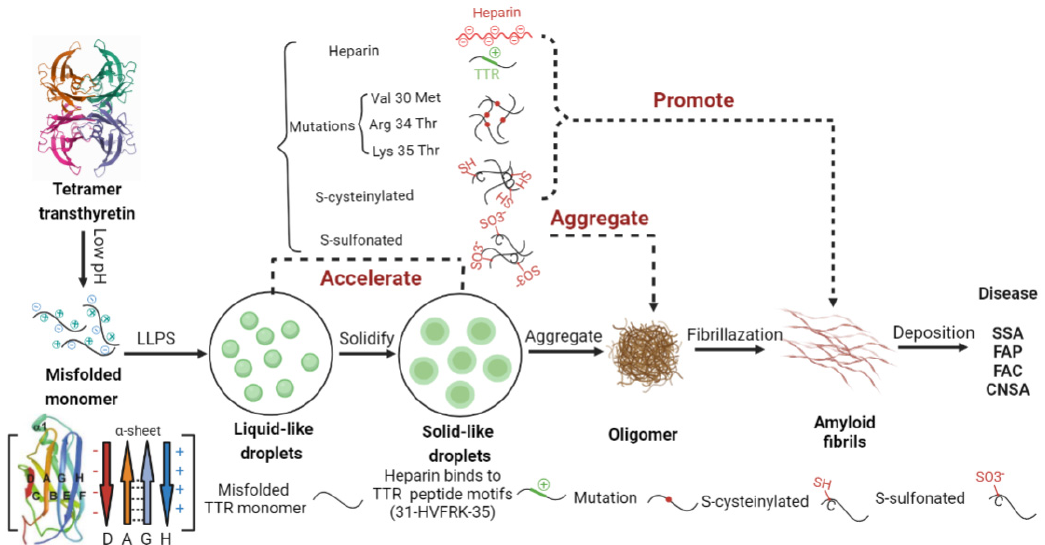
Figure 5. A model for irreversible aggregation of TTR through a liquid-solid phase transition. TTR disassociates into monomers at low pH, then forms oligomers through the liquid-to-solid phase transition, and finally fibrosis to amyloid fibrils that lead to disease. Mutations or PTMs destroy phase separation, leading to the formation oligomer or amyloid fibrils directly.